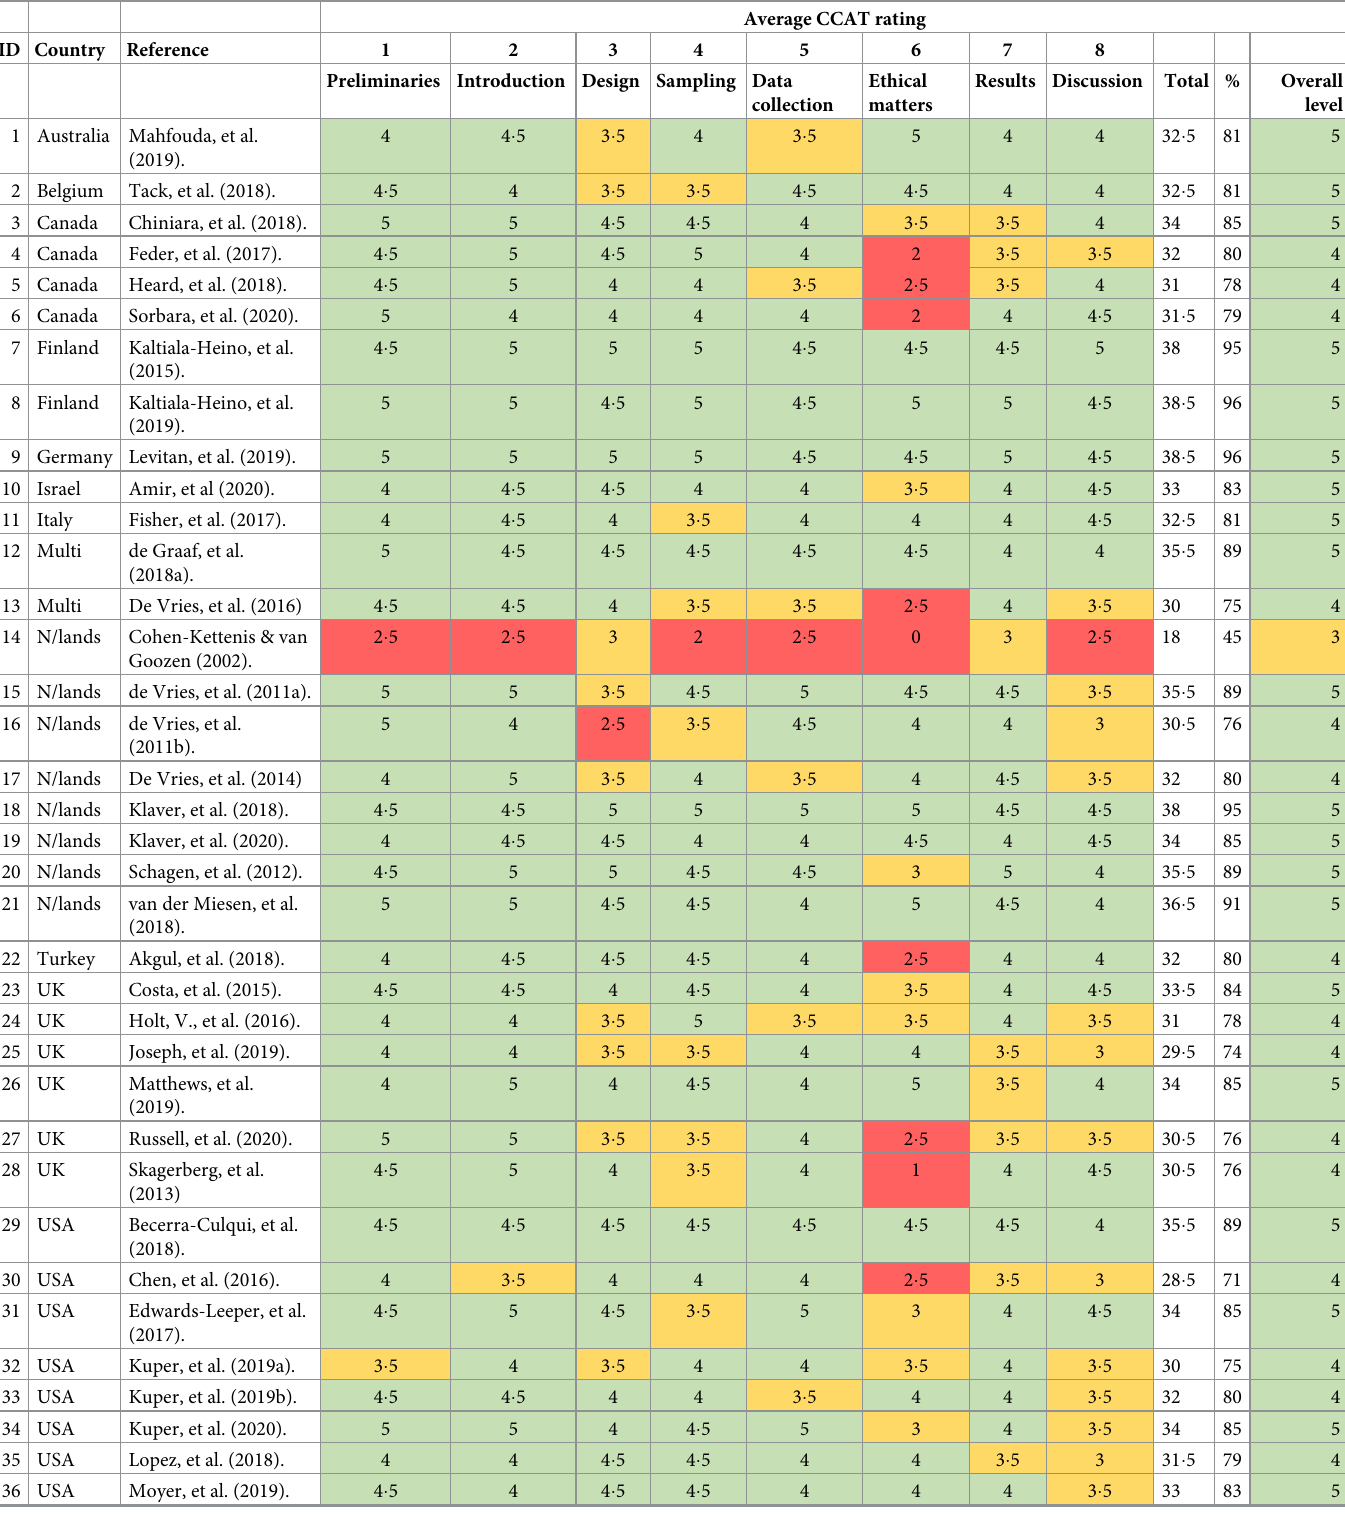
Table 4. Quality ratings using Crowe Critical Appraisal Tool